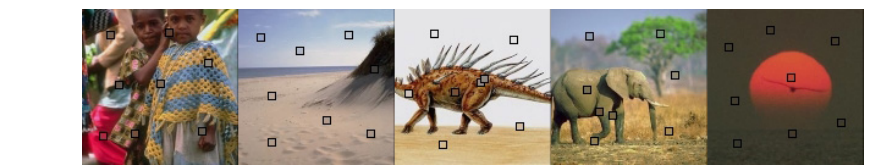
Figure 4. Locations of code vectors within an image.